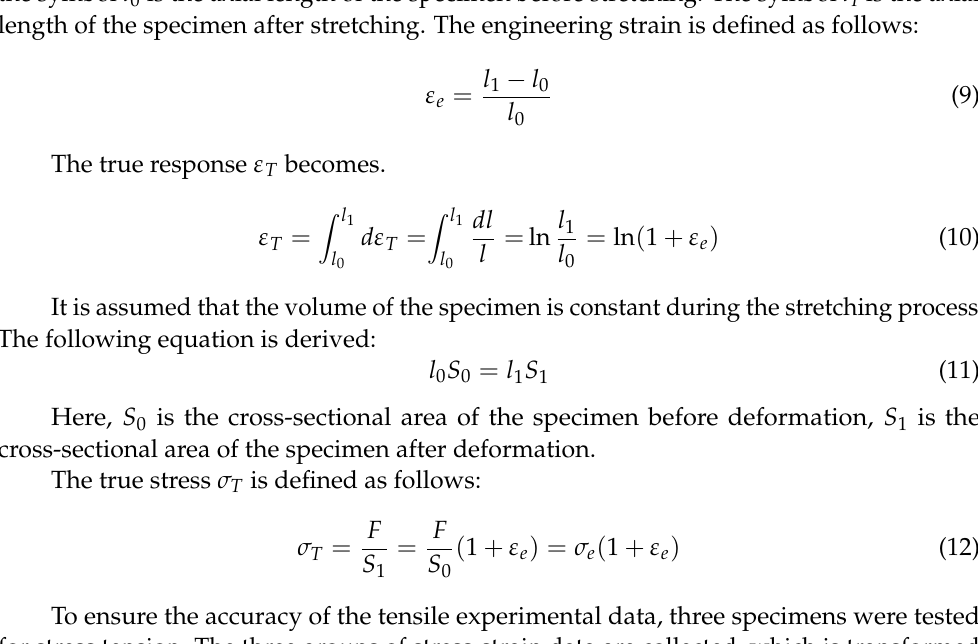
Figure 7. 2A12 aluminum alloy tensile specimen.